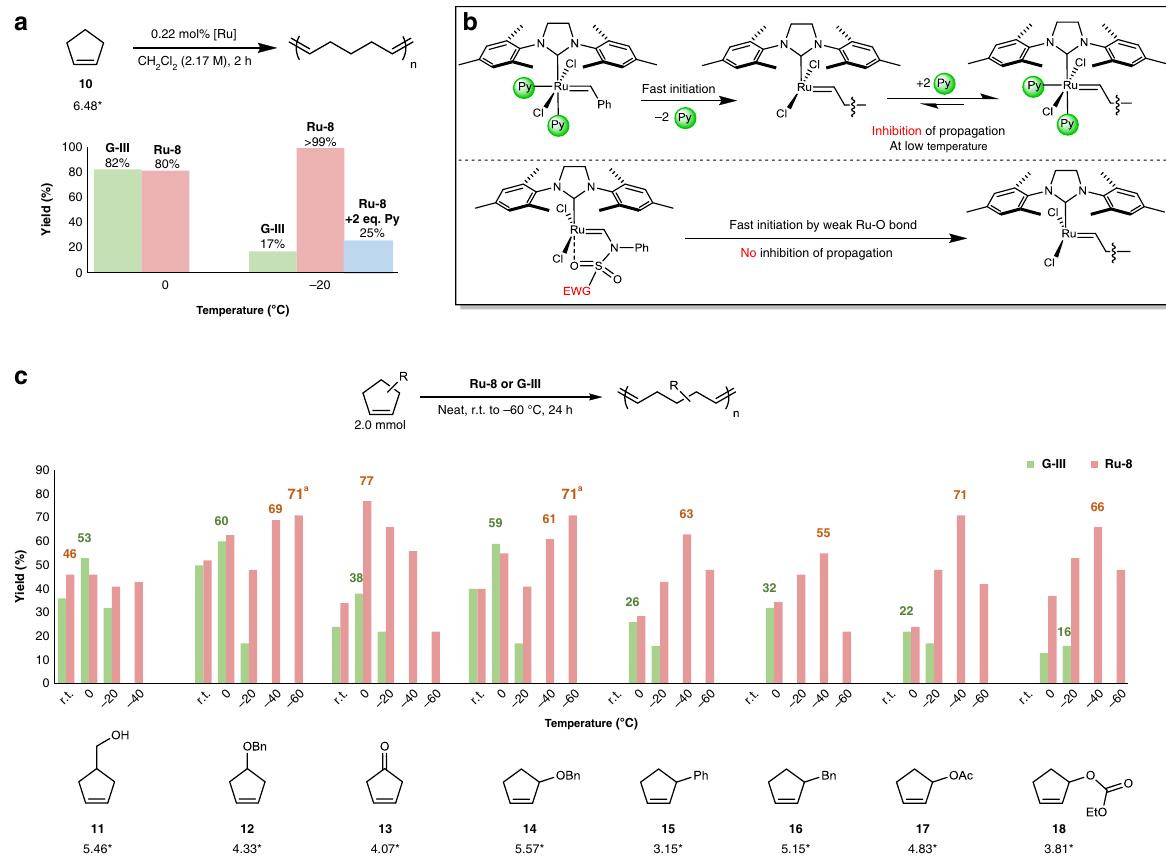
Fig. 5 ROMP of cyclopentene derivatives at low temperatures. a Comparing G-III and Ru-8 in the ROMP of cyclopentene at various temperatures. b Outlining pyridine interruption during propagation at low temperature. c ROMPs of functionalized cyclopentenes. After quenching with ethyl vinyl ether, the polymer was isolated by precipitation in methanol or hexane. a In dichloromethane (2.0 M). * Ring strain (kcal/mol) calculated at the G3// RB3LYP/6 – 31 + + G(2df,2p) level of